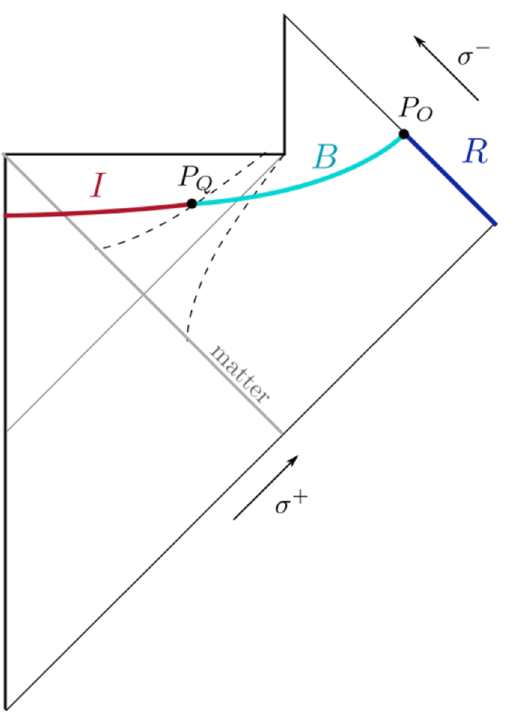
Figure 4 . Island in the evaporating black hole. The Observer at P O collects the radiation in region R . The island is I , and I [ B [ R is a Cauchy slice. The endpoint of the island is the quantum extremal surface P Q . The dashed lines are the apparent horizon and the curve of extremal